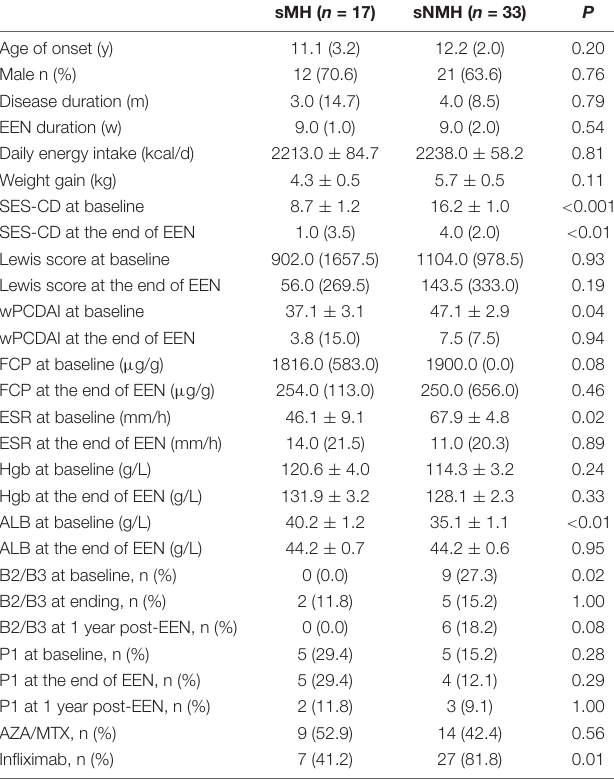
TABLE 1 | Characteristics and clinical information for patients with Crohn’s disease.